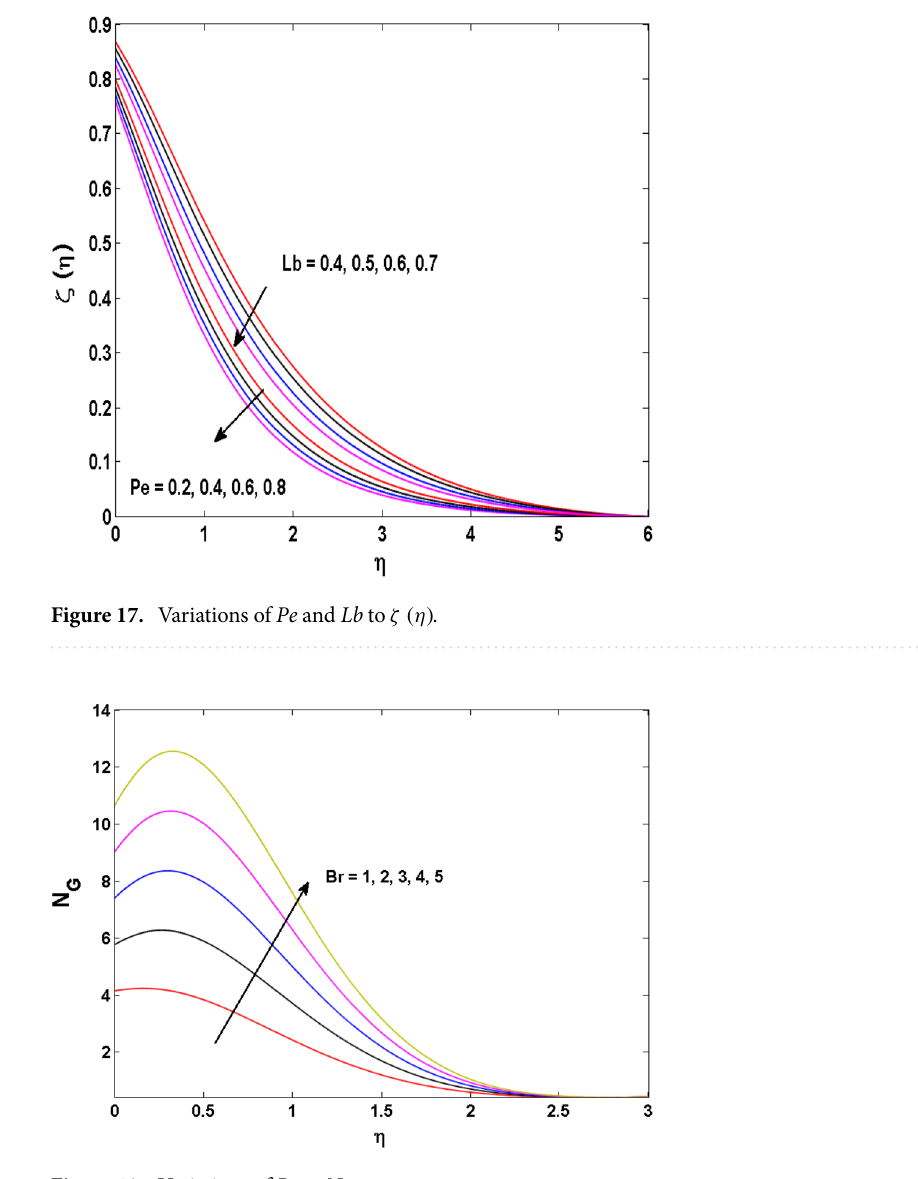
Figure 18. Variations of Br to N G